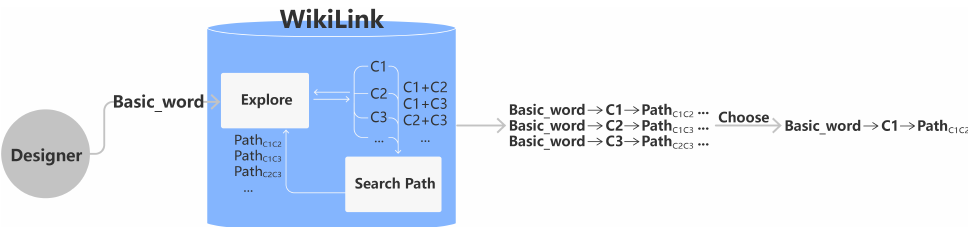
Figure 7. The flow of concepts exploration in WikiLink.